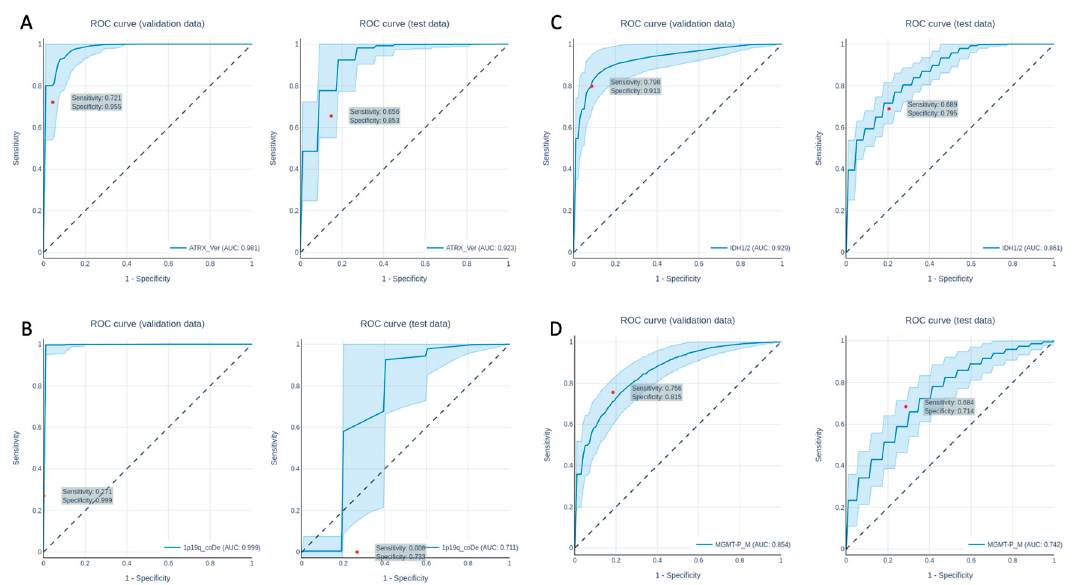
Figure 4. ROC curves of the prediction of the ATRX expression loss ( A ), the 1p19q co-deletion ( B ), the IDH1/IDH2 mutation ( C ) and the MGMT-status ( D ) in the validation data set (left) and the test data set